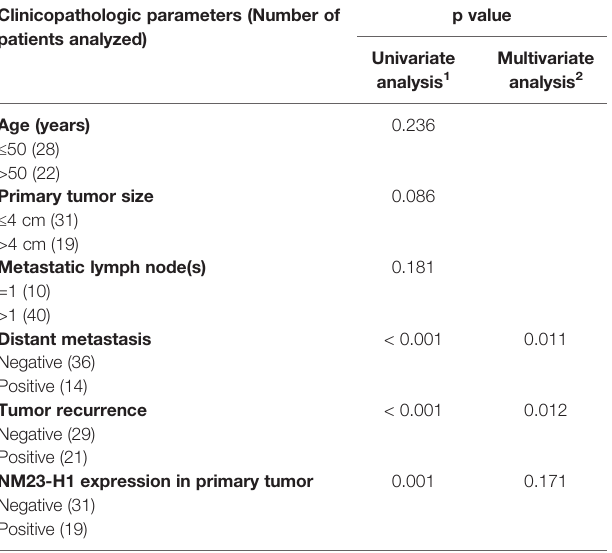
TABLE 2 | Survival analysis of 50 patients with head and neck squamous cell carcinoma with resectable cervical metastasis treated by postoperative radiation. Clinicopathologic parameters (Number of patients analyzed)